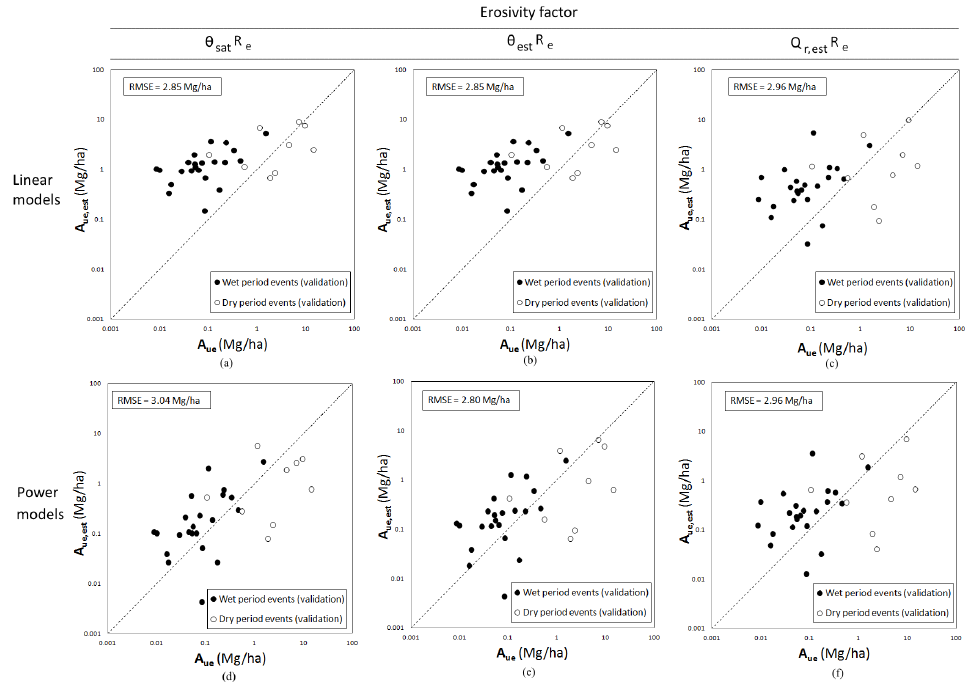
Figure 4. Testing of the A u e vs. θ R e and the A u e vs. Q r R e models with the validation subset. Linear models (a) , (b) , (c) : SM4E model and satellite soil moisture (a) ; SM4E model and estimated soil moisture (b) ; USLE-M model and estimated runoff coefficient (c) . Power models (d) , (e) , (f) : SM4E model and satellite soil moisture (d) ; SM4E model and estimated soil moisture (e) ; USLE-MM model and estimated runoff coefficient (f) .